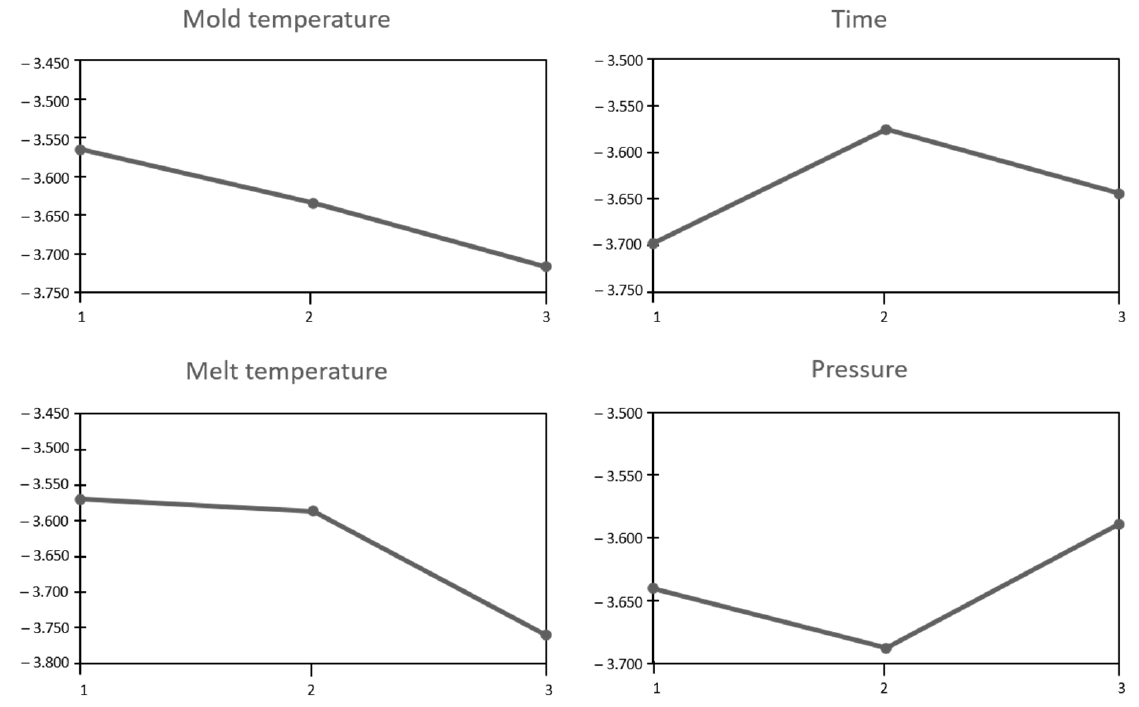
Table 7. Average responses of S/N ratio and delta.